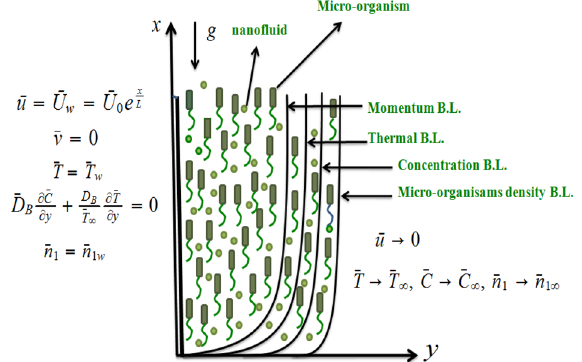
Figure 1. Physical